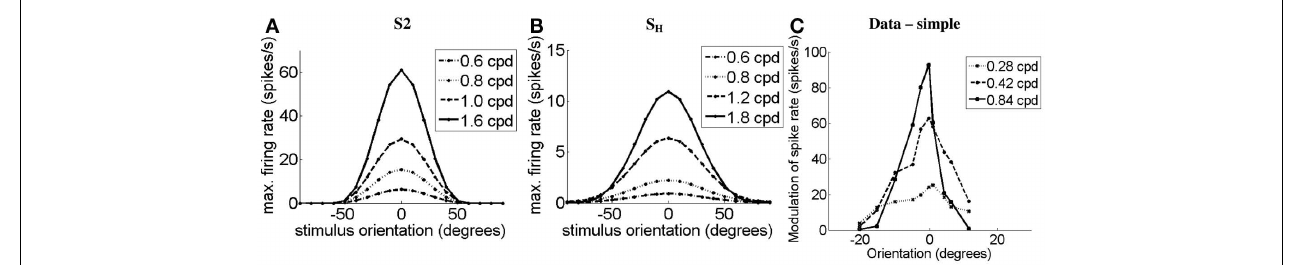
Gabor patches of different SFs. Legends indicate the SF in cpd. In each plot the y -axis represents the maximum firing rate in spikes/seconds, and the x -axis represents the orientation of the grating or Gabor patch stimulus in degrees.